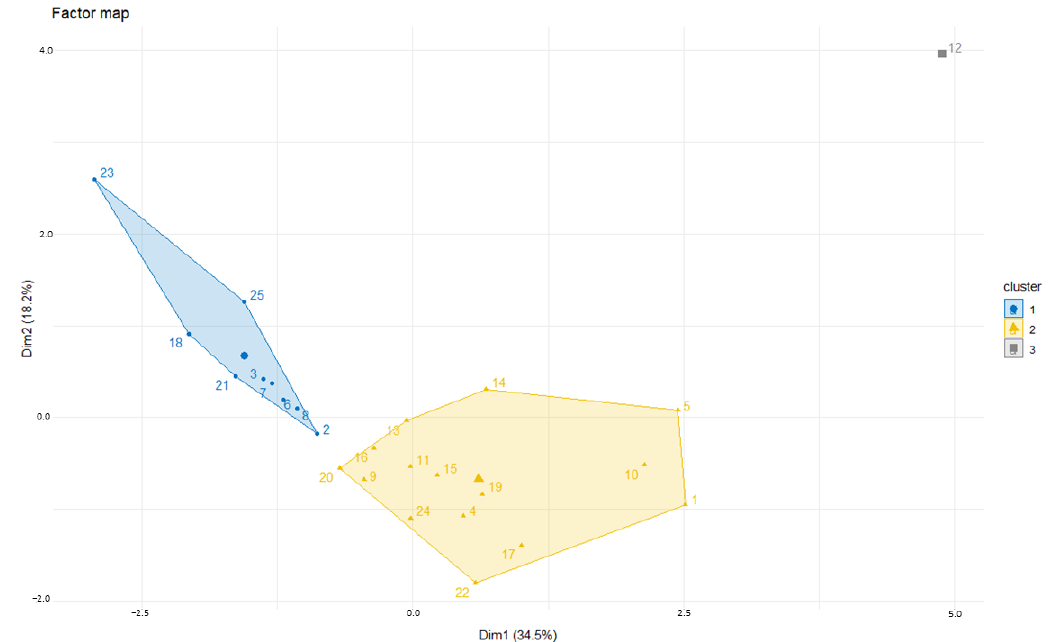
Figure 2. PCA graph of variables for each quadrant. Quadrant 1 (Q1) was represented by CCL-2 β ); no cytokines contributed in quadrant 4. Then, a factor map was developed using and IL-21; quadrant 2 (Q2) by IL-13, IL-8 and TNF- α; quadrant 3 (Q3) by IL10, IL-6 and TGF- β. The x -axis plotted principal component 1 (Dim 1), and the y -axis plotted principal component 2 (Dim 2). Variance explained was represented as a percentage. (11 patients) and cluster 3 (1 patient) (Figure 3).